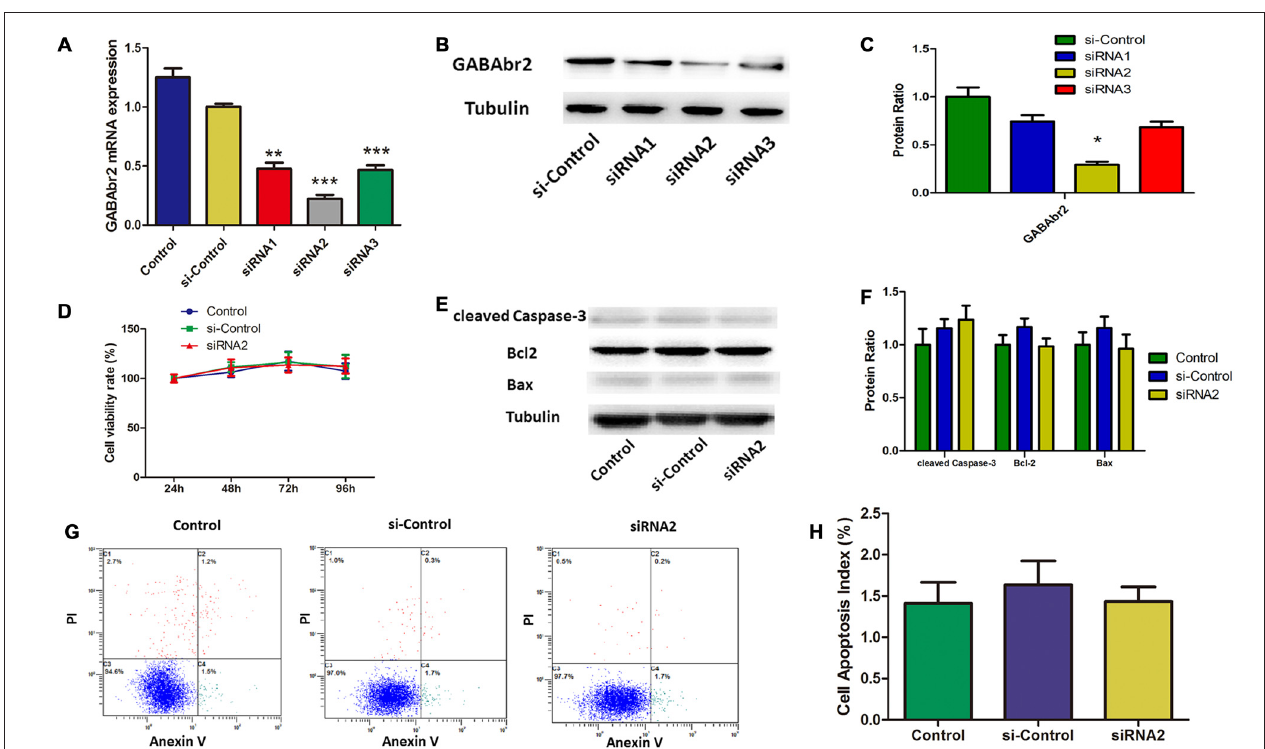
FIGURE 4 | Small interfering RNA (siRNA) silenced GABA B 2 expression without interfering RGCs survival. (A–C) GABA B 2 mRNA expression (A) and GABA B 2 protein level (B,C) . Up on transfected with siRNAs against GABA B 2 and control siRNA. ∗∗ p < 0.01, ∗∗∗ p < 0.001 vs. basal level. (D) Time course of cell viability detected by CCK-8 assay in RGCs transfected with indicated siRNAs. Cell viability was quantified based on three independent experiments (mean ± SD). (E,F) Expression of cleaved caspase-3, bax and bcl-2 detected by Western blotting in RGCs transfected with indicated siRNAs. The detected protein bands are normalized to the signal of α -tubulin. The level of protein in each group was expressed as the value relative to the control. The data represent the mean ± SD of three independent experiments. ( ∗ p < 0.05, vs. control). (G,H) Cell apoptosis detected by Annexin V and PI staining methods in RGCs transfected with indicated siRNAs. C4 quadrant (Annexin V + /PI − ) indicates the percentage of apoptotic cells. Representative experiments are shown. Values represent the mean ± SD of three independent